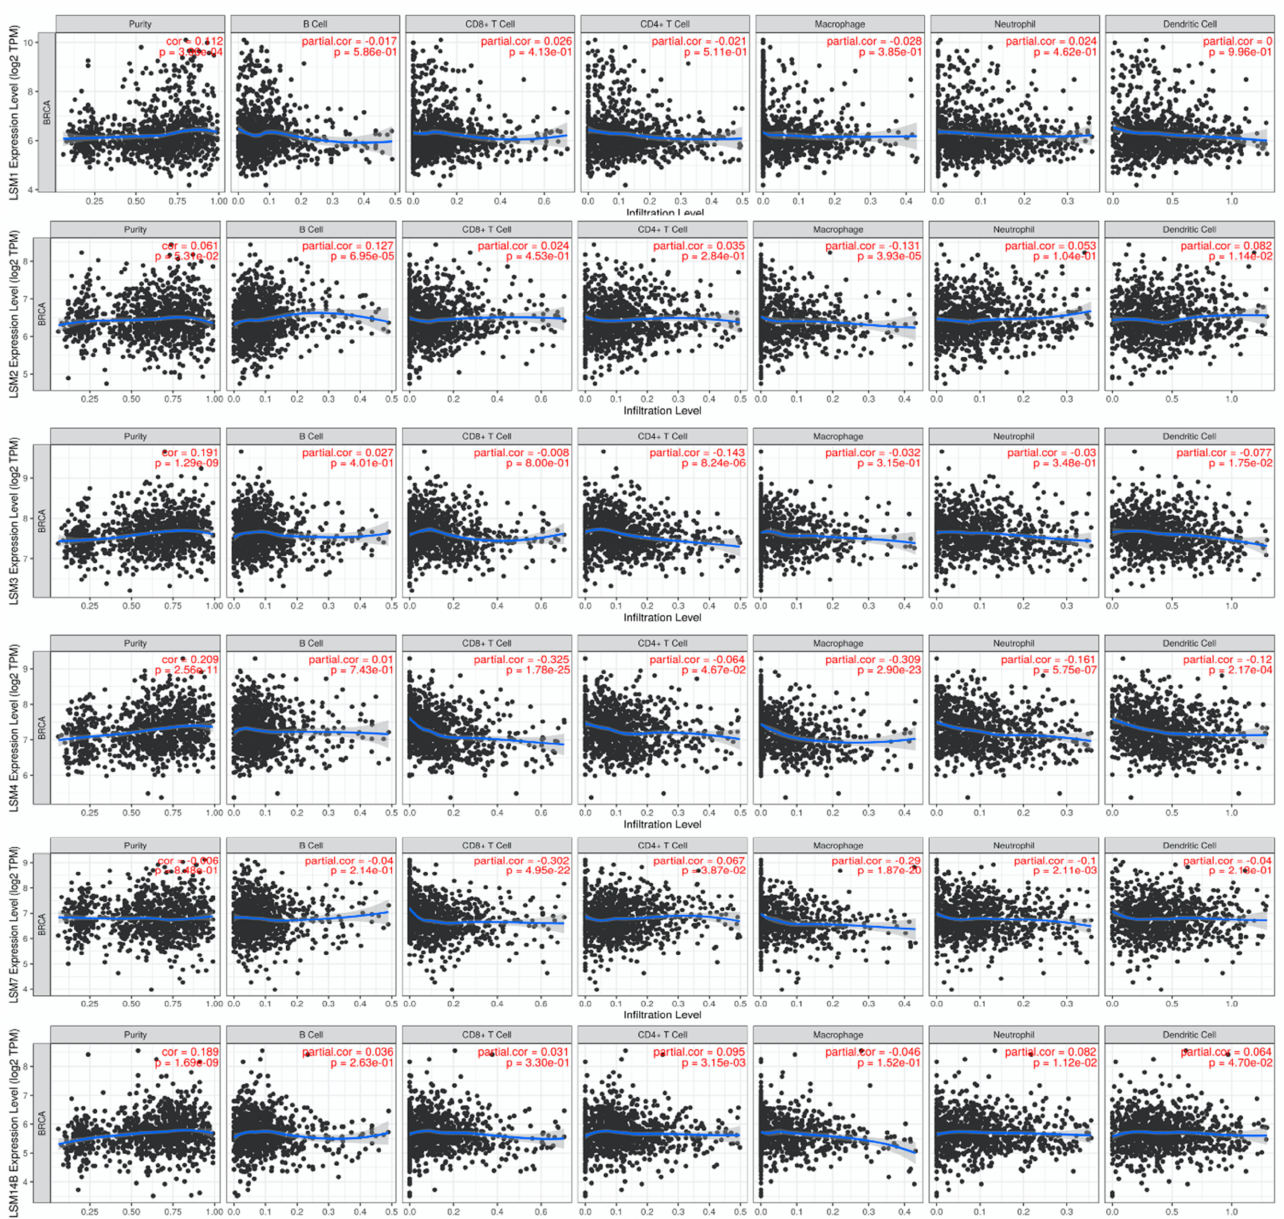
Figure 5. Correlations of LSM1, LSM2, LSM3, LSM4, LSM7, and LSM14B expressions with immune infiltration profiles in breast cancer (from TCGA database). The figures show the each LSM gene expression was associated with tumor purity and several tumor-infiltrating immune cell markers, namely CD8+ T cells, B cells, CD4+ T cells, neutrophils, macrophages, and dendritic cells. Spearman correlations were applied to describe correlations between LSM family genes and the above-mentioned immune cells ( p < 0.05 was accepted as statistically